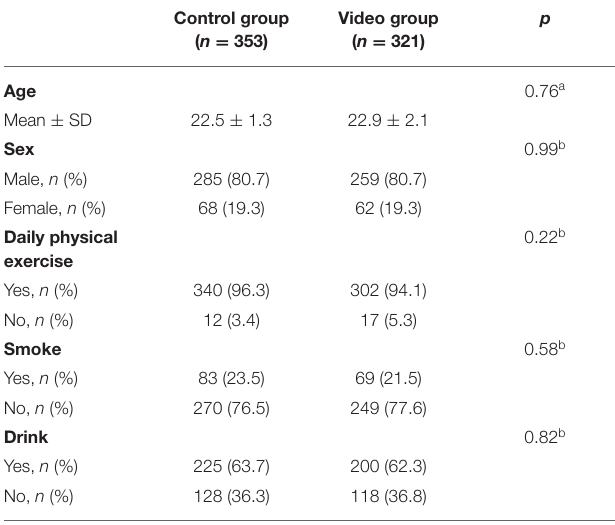
TABLE 1 | Demographic characteristics for control group and video group ( n = 674).